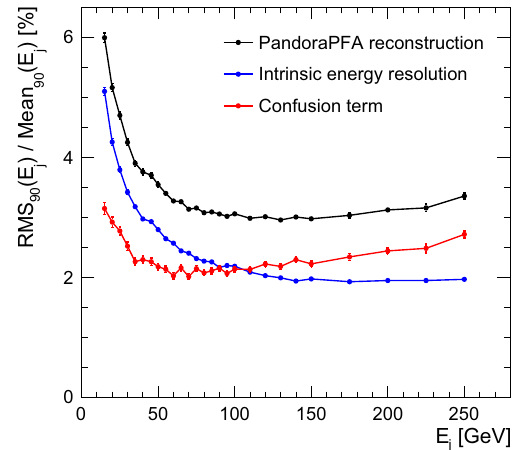
Fig. 1 Jet energy resolution, given by RMS 90 / Mean 90 (see Sect. 3 for details of the jet energy resolution definition), obtained with the Pan- doraPFA algorithm for the ILD detector concept. The intrinsic energy resolution is obtained by using the information of which particle is responsibleforagivenenergydepositioninthecalorimeterfromGeant4 in the pattern recognition, ensuring correct matching of particle tracks and calorimeter clusters. The confusion term is the contribution to the resolution originating from mistakes in the assignment of energy depo- sitions to reconstructed particles, defined as the quadrature difference between the total and the intrinsic energy